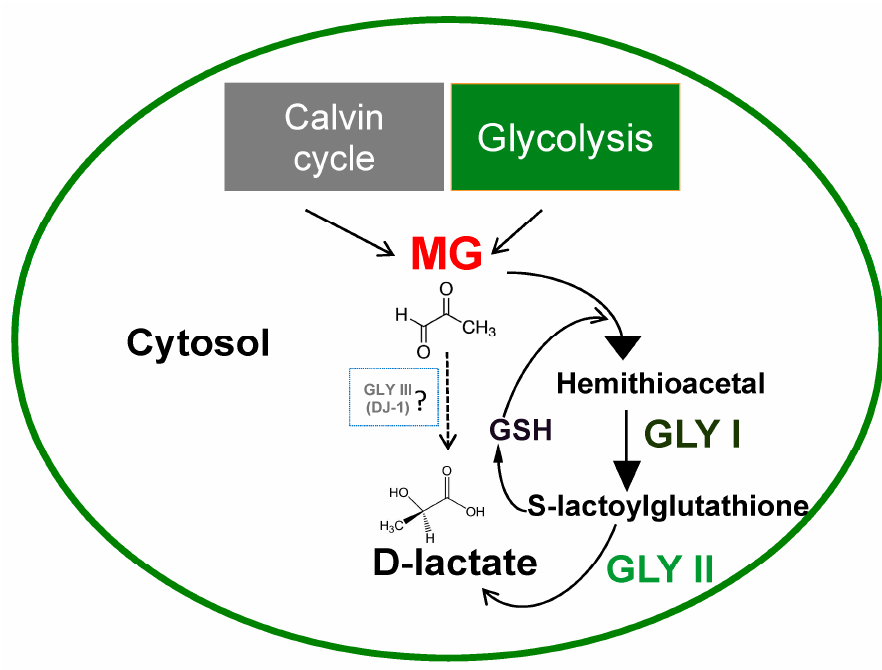
Figure 1. Major routes of methylglyoxal (MG) production and detoxification system in plants. Methylglyoxal is produced as a result of spontaneous dephosphorylation of glyceraldehyde-3 phosphate (G3P) in the Calvin cycle of photosynthesis and from the dephosphorylation of triose phosphate intermediates (TPI) during glycolysis in the cytosol of plant cells. The major routes of enzymatic detoxification of MG in plants are by the two-step glyoxalase pathway mediated by GLYI and GLYII, which depends on the presence of reduced glutathione. A one-step process mediated by GLYIII that does not require reduced glutathione has also been proposed, but the functional role of this enzyme in MG detoxification is debatable.